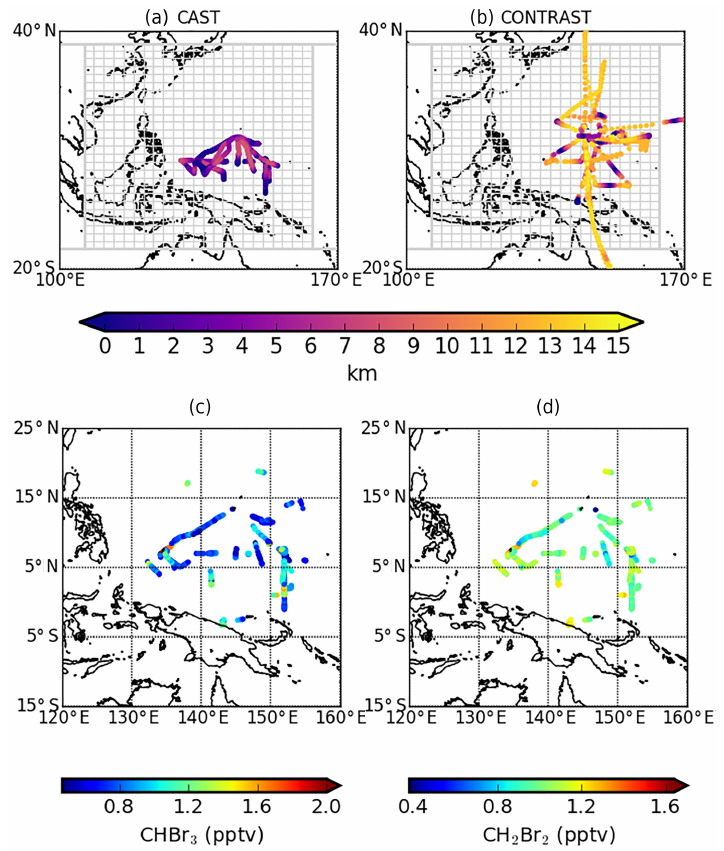
Figure 1. Distributions of data from the (a, c) CAST and (b, d) CONTRAST aircraft campaigns during January and February 2014. Data are described on 2 ◦ (latitude) × 2.5 ◦ (longitude) GEOS-Chem grid boxes. The top panels show the altitude of data collected by both campaigns. We superimpose the flux inversion domain (grey lattice), consisting of 600 grid boxes between 105 and 165 ◦ E and 15 ◦ S–25 ◦ N, four larger neighbouring regions, and the rest of world. The bottom panels show the distributions of boundary layer (less than 2.5km) CHBr 3 (pptv) and CH 2 Br 2 (pptv) mole fraction